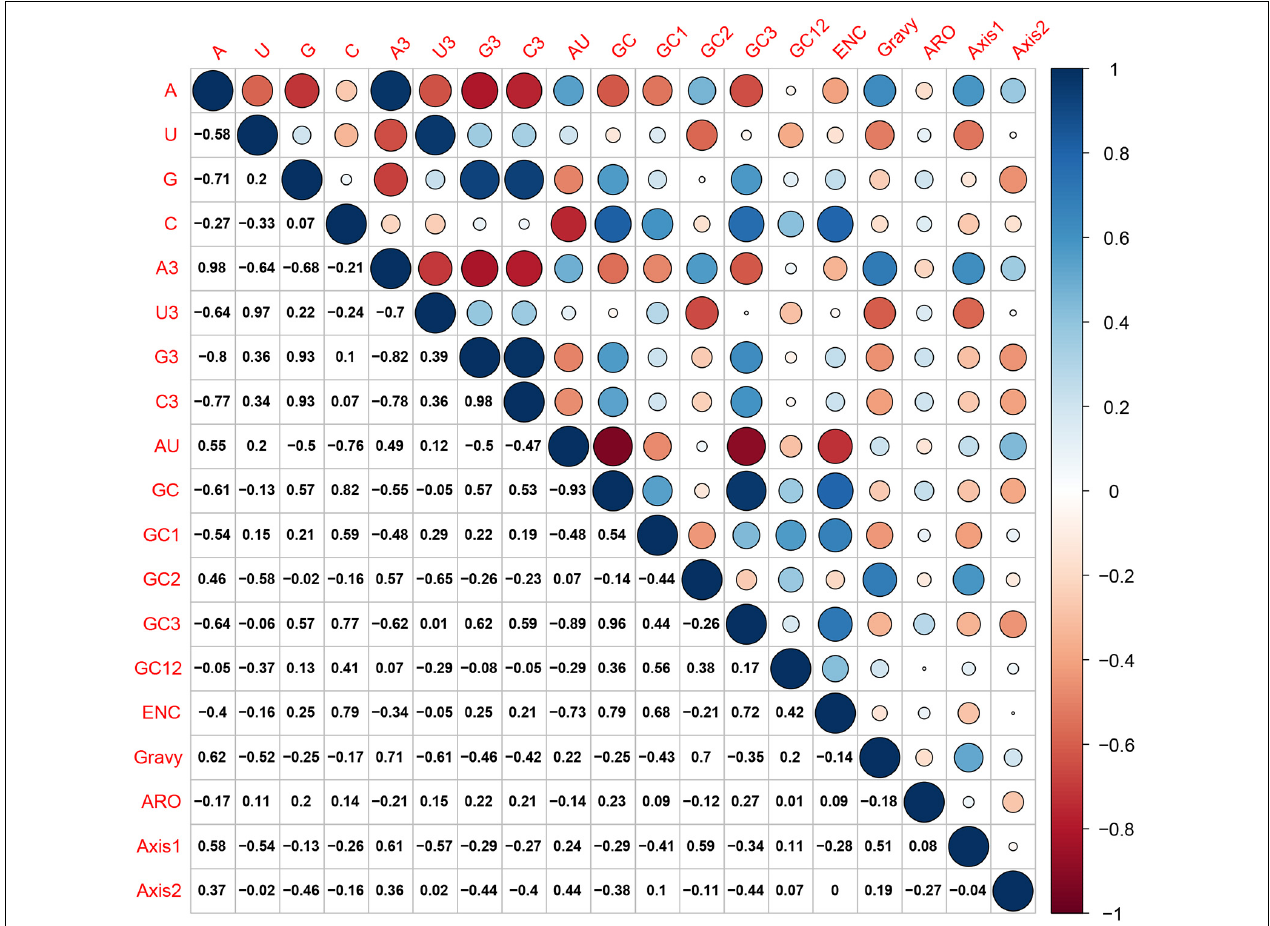
FIGURE 4 | Spearman’s correlation analysis between compositional constraints, ENC, Gravy, ARO, and the first two principal axes of COA in HTNV whole genome. Dark blue, positive correlation; Dark red, negative correlation. The high color darkness means a highly significant correlation and vice-versa.